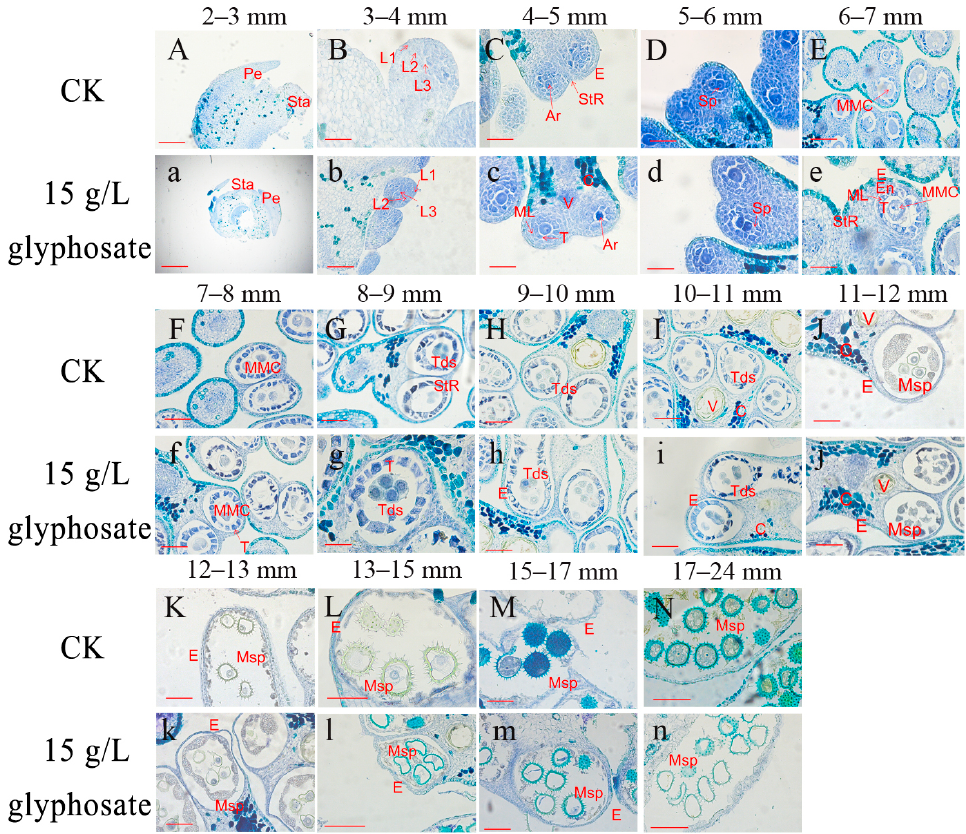
Figure 5. Cytological observations from glyphosate treatment on male gametophyte development.